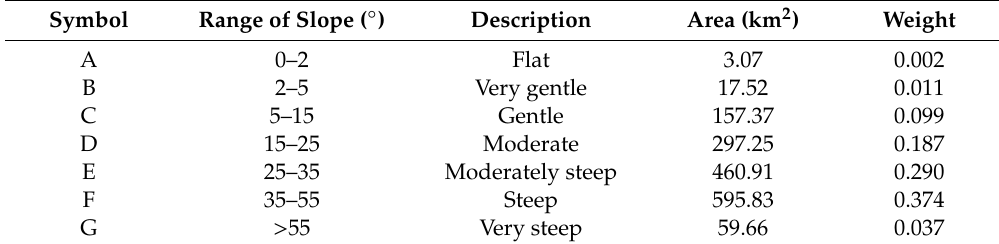
Table 1. Slope classification of Gongga Mountain.